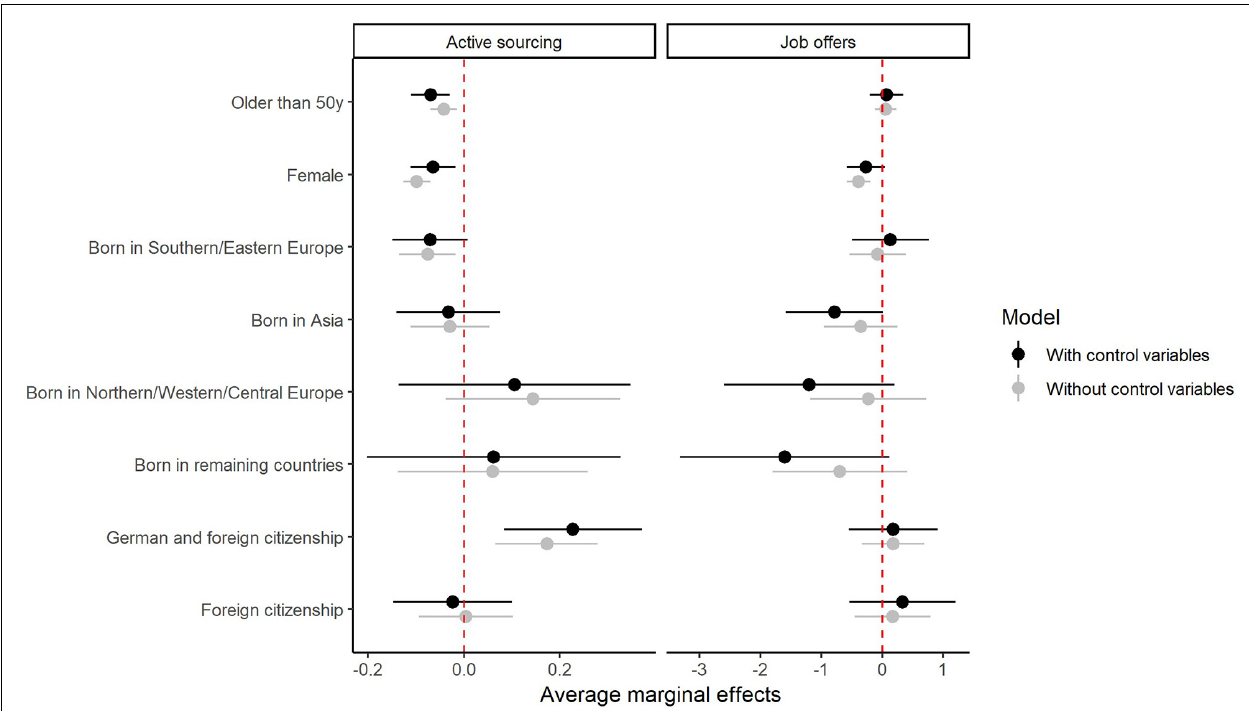
FIGURE 5 | Average marginal effects for the two dependent variables, active sourcing and job offers. The first column refers to active sourcing, the second column to job offers. The reference categories are younger than 50 years, male, born in Germany, and German citizenship. The average marginal effects are represented by dots, the 95% confidence interval is represented by the horizontal lines at each point. Dark lines represent the effects with control variables, light lines the effects without control variables. The vertical dashed line at zero represents the threshold for positive and negative